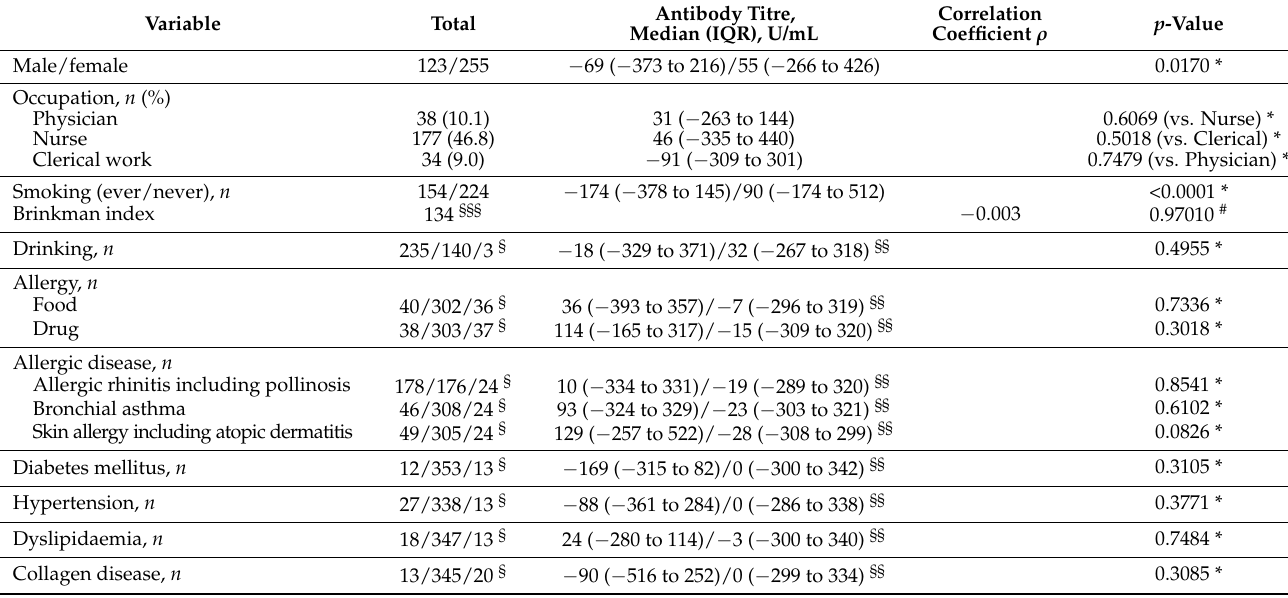
Table 2. Age-adjusted data of median antibody titres ( N =